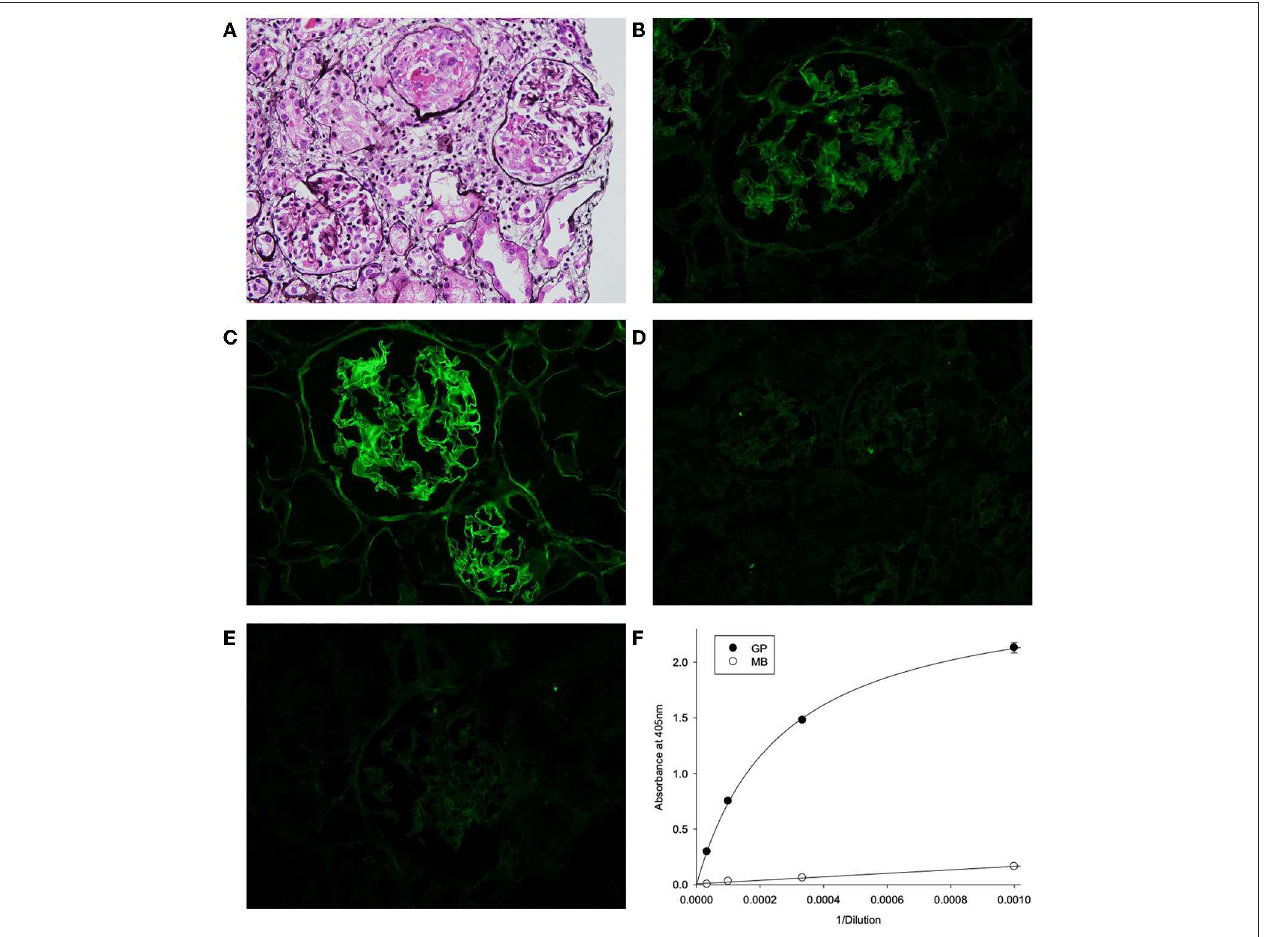
FIGURE 1 | (A) Kidney lesions in post-HSCT patient showing characteristic features of crescentic glomerulonephritis, with > 90% of the 32 glomeruli sampled displaying cellular or fibrocellular crescents, with segmental fibrinoid necrosis and with extensive acute tubular injury and focal, 10–20% interstitial fibrosis and tubular atrophy (Jones’ silver stain). (B–E) Binding of patient serum antibodies to frozen sections from normal human kidney (immunofluorescent staining). (B) Distinct linear staining of GBM observed on intact kidney section, which is strongly increased after pre-treatment with acidic urea (C) . (D) There is no staining with normal human serum (1:50). (E) GBM staining was abolished by adsorption of patient serum on α 3NC1-coated magnetic beads (E) , which removed 95% of α 3-antibody as demonstrated by testing of original (GP) and absorbed (MB) serum using indirect ELISA of on α 3NC1-coated plate (F)